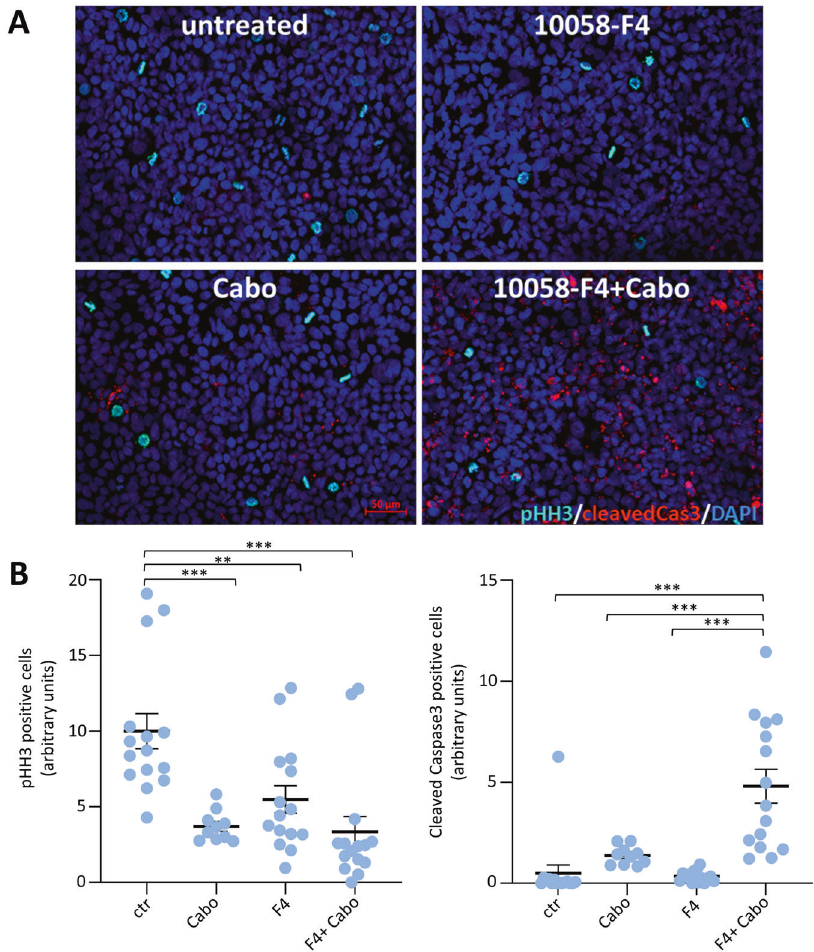
(control), treated for 36 h with cabozantinib (3 µM; Cabo), 10058-F4 (60 µM), or 10058-F4 + Cabozantinib (10058-F4 + Cabo). Note a drastic increase of apoptotic cells in the presence of 10058-F4 + Cabozantinib. B Graphs reporting quanti fi cations of anti-phosphoHistoneH3